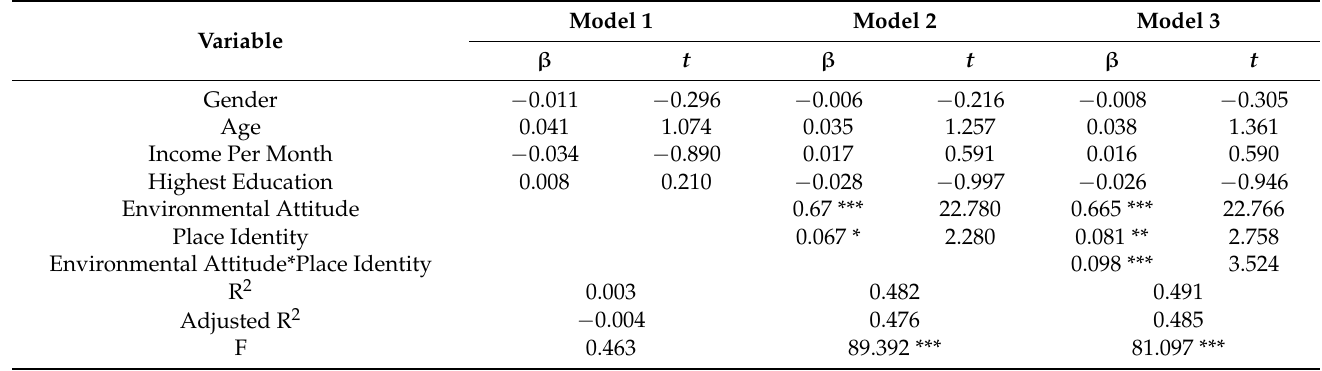
Table 12. Moderating effect test of place identity influence on the interaction between environmental attitude and pro-environmental